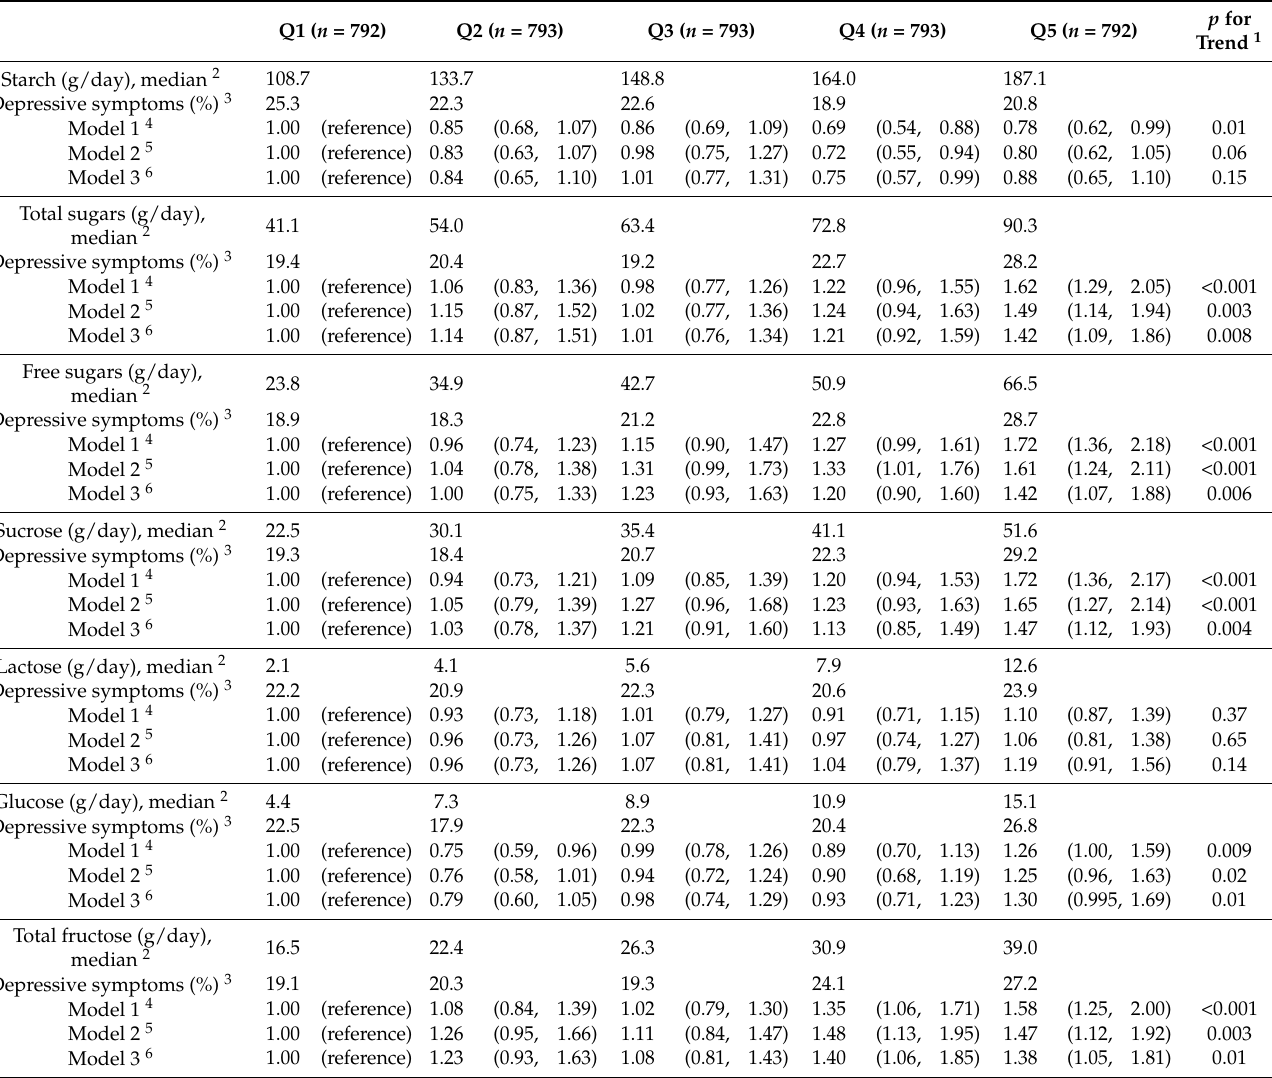
Table 5. Odds ratios (95% confidence intervals) for depressive symptoms according to the quintiles of the energy-adjusted intakes of starch and sugars in 3963 young Japanese